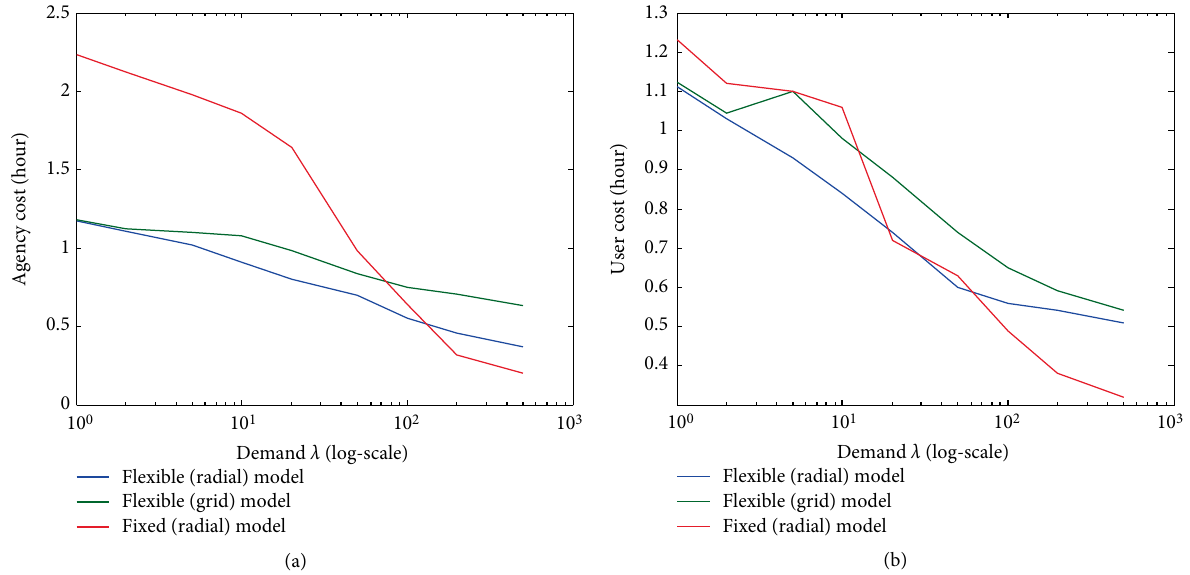
Figure 6: Agency and user cost of three transit systems. (a) Agency cost versus demand density levels. (b) User cost versus demand density